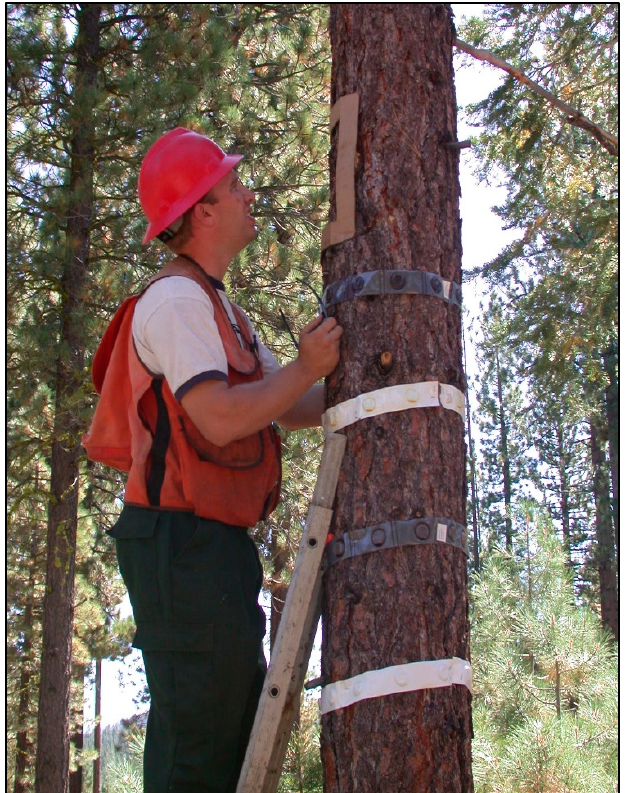
Figure 7. Fettig et al. [56] examined nonhost angiosperm volatiles and verbenone for protecting individual ponderosa pines ( Pinus ponderosa ) from western pine beetle ( Dendroctonus brevicomis ) in California. A combination of verbenone and nonhost angiosperm volatiles significantly reduced attack densities and mortality of baited trees. Components were formulated in four bubble-capsule bands based on similarity in chemical structure (i.e., alcohols, aldehydes, guaiacol (a phenol), and verbenone (a ketone)). This research informed development of Verbenone Plus in subsequent years [59]. Photo credit: C.J. Fettig, USDA Forest Service.